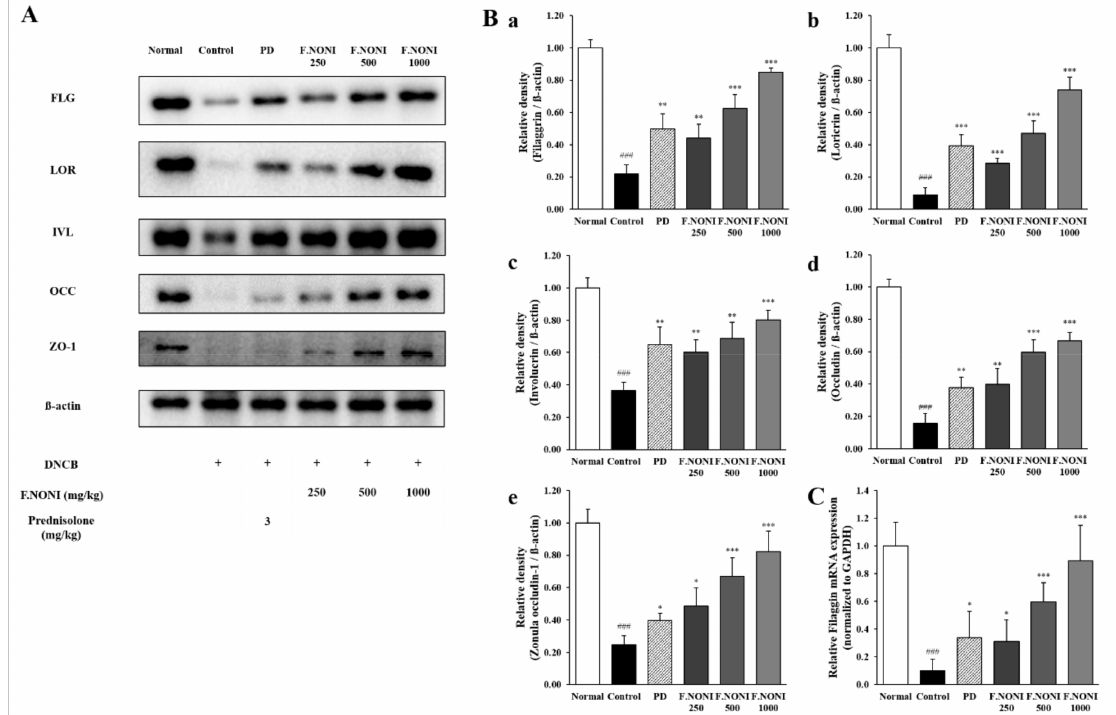
Figure 7. E ff ect of F.NONI on skin barrier dysfunction in the dorsal skin of AD-induced NC / Nga mice. ( A ) Protein levels of FLG (34 kDa), LOR (26 kDa), IVL (68 kDa), OCC (59 kDa), ZO-1 (187 kDa), and ß-actin (43 kDa) were analyzed using Western immunoblotting. ( B ) The protein levels of ( a ) FLG, ( b ) LOR, ( c ) IVL, ( d ) OCC, and ( e ) ZO-1 were quantified by band density and normalized to ß-actin. The results were presented as mean ± SEM ( n = 4). ( C ) Gene expression levels of pro-FLG were analyzed in dorsal skin using RT-qPCR. The results were presented as mean ± SEM ( n = 5); ### p < 0.001 vs. normal, * p < 0.05, ** p < 0.01, *** p < 0.001 vs. control. Normal, untreated group; Control, atopic dermatitis induced by DNCB; PD, positive control (prednisolone 3 mg / kg) treated group; F.NONI (fermented Morinda citrifolia 250, 500, or 1000 mg / kg) treated group; FLG, filaggrin; LOR, loricrin; IVL, involucrin; ZO-1, zonula occludens-1; OCC, occludin; pro-FLG,